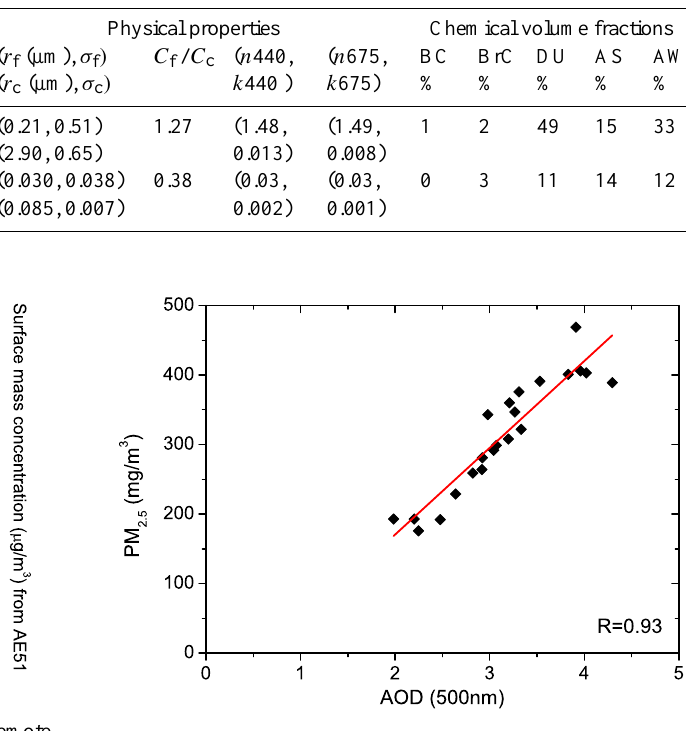
Fig. 13. Comparison of PM 2 . 5 with AOD measurements during the two heavy haze events in Beijing